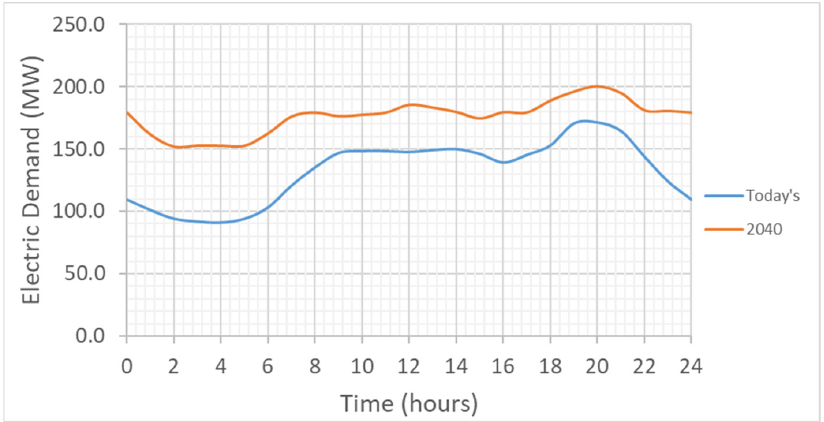
Figure 3. Current electricity demand profile and forecast of the island of Lanzarote for 2040.